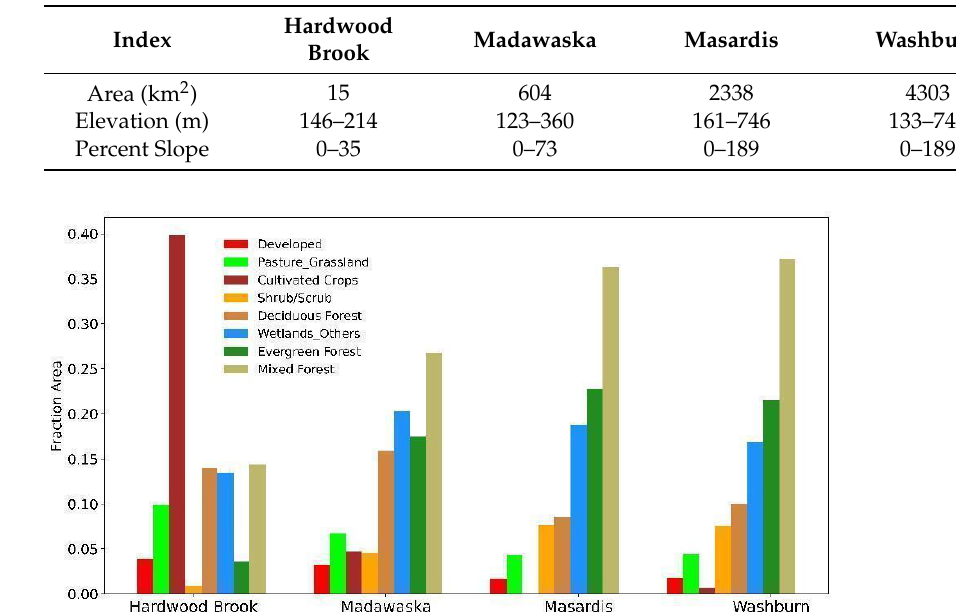
Table 1. Geographic characteristics of selected sub-basins.